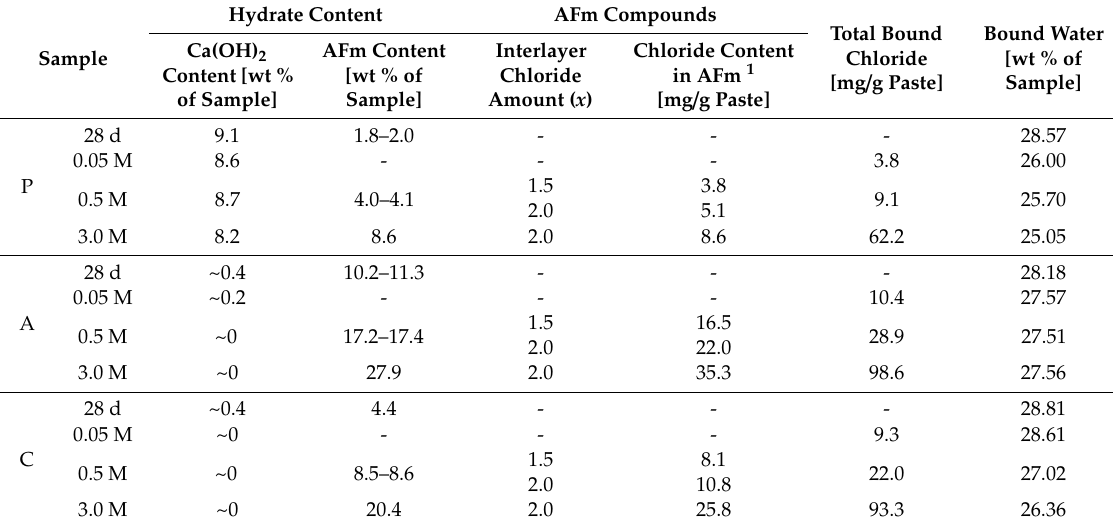
Table 5. Thermogravimetry results of the paste